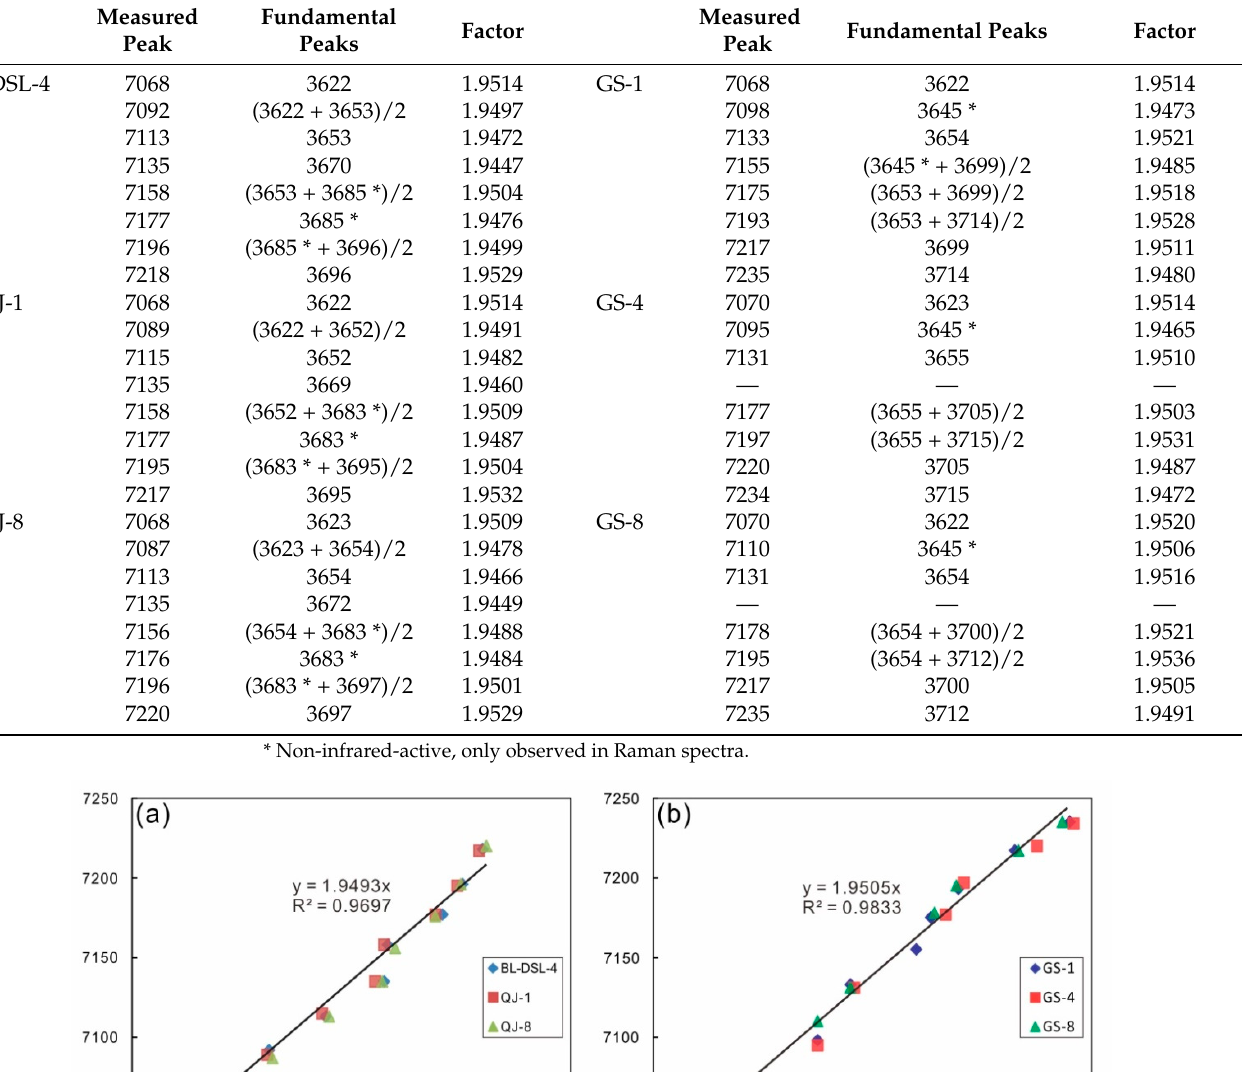
Table 5. The major NIR bands in 7000~7250 cm − 1 for related samples and their corresponding MIR peaks (cm − 1 ).